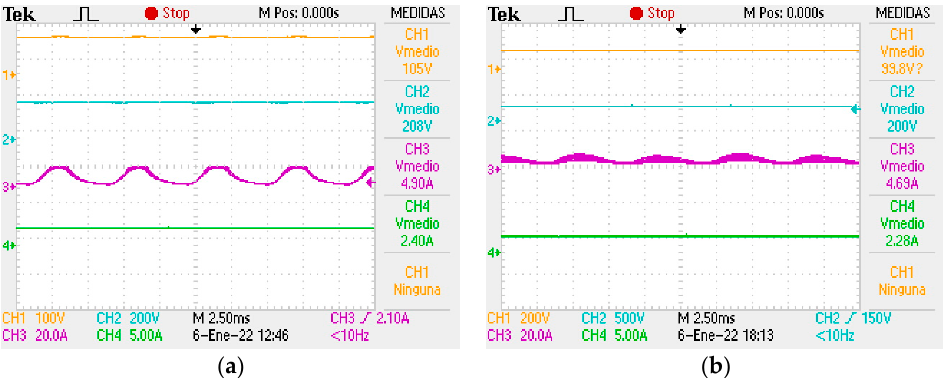
Figure 12. DC voltage and current signals from converter at full load: ( a ) 2L and ( b ) 3L.